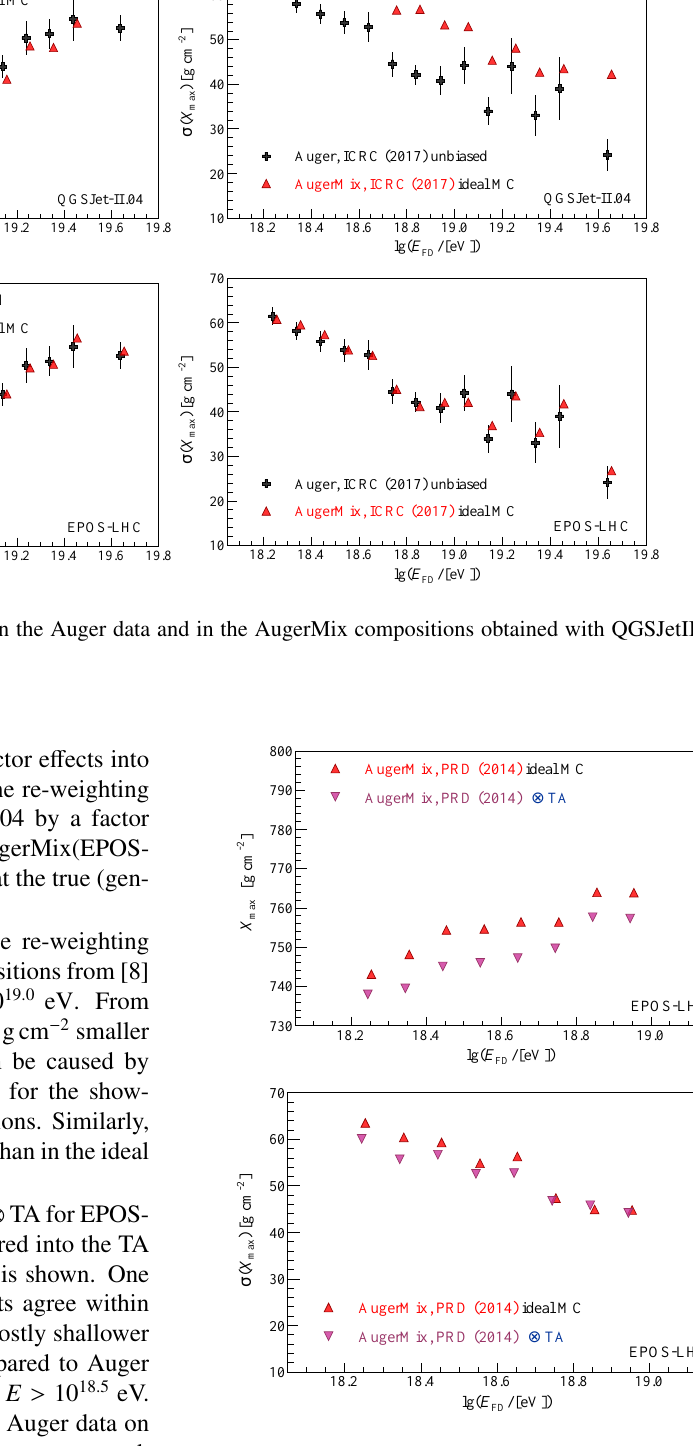
(cid:105) (top) and σ ( X Figure 7. (cid:104) X ) (bottom) for the AugerMix max max composition of EPOS-LHC at the generation level (ideal MC) and after the simulations and analysis for the TA BR / LR detector ( ⊗ TA).